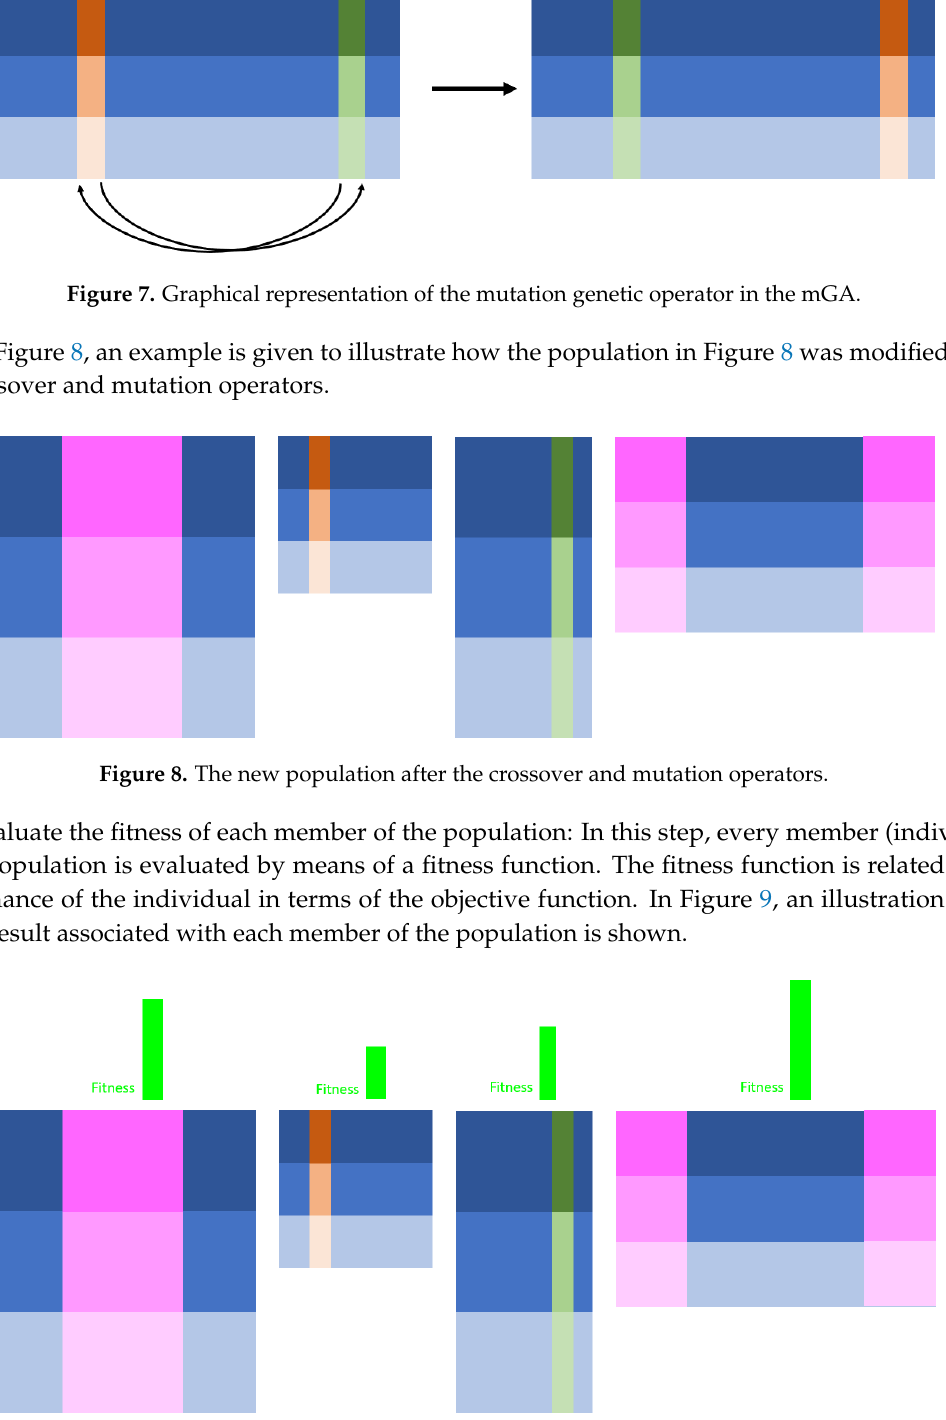
Figure 9. An example of the fitness associated with each member of the